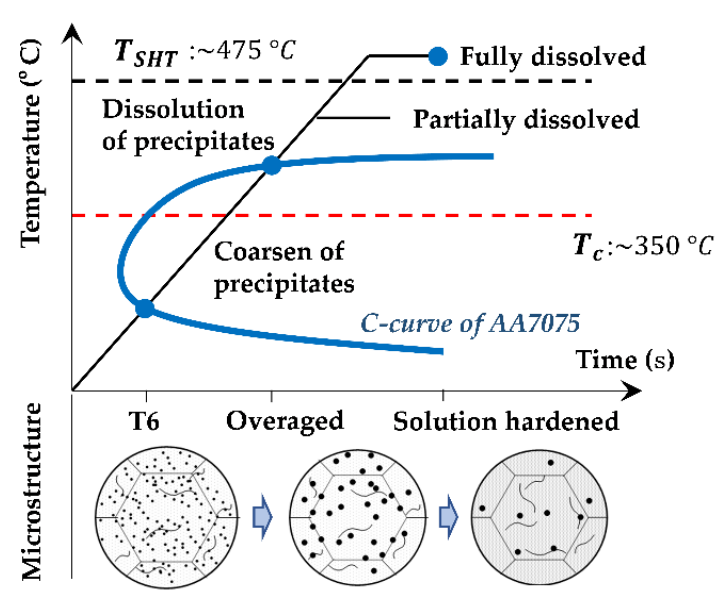
Figure 2. Schematic of precipitation sequences and kinematics during heating of AA7050 with different heating rates.